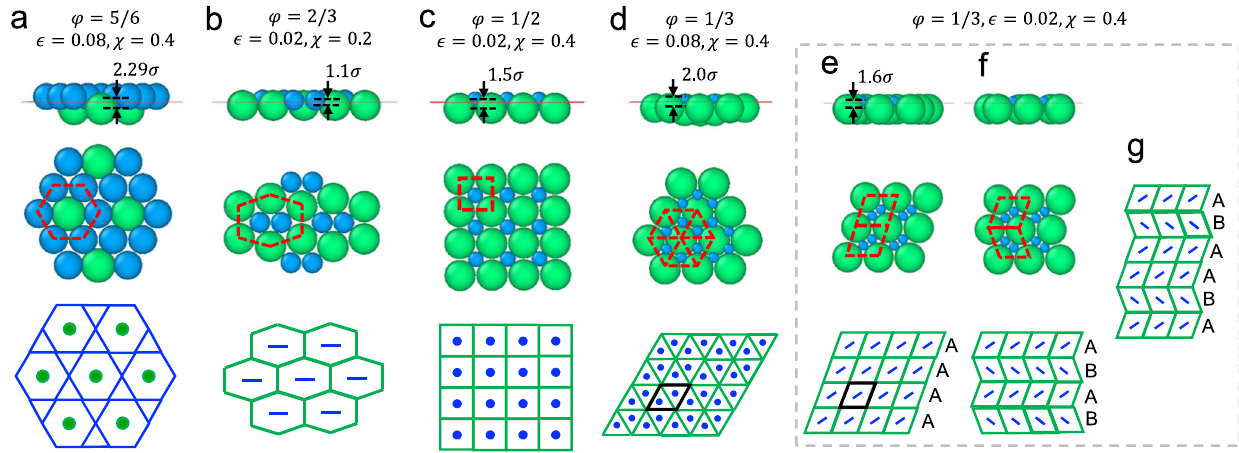
Fig. 4 | Monolayer BNSLs obtained at different NP size ratios. a AB 3 -type BNSL with Kagome-hexagonal order of NPs formed at φ =5 = 6. b AB-type BNSL with strainedhoneycomborderat φ =2 = 3. c AB-typeBNSLwithsquareorderat φ =1 = 2. d AB 2 -typeBNSLwithtriangularorderat φ =1 = 3. e – g AB 2 -typeBNSLwithrhombic order showing two equivalent ground-state con fi gurations at φ =1 = 3 ( e , f ).